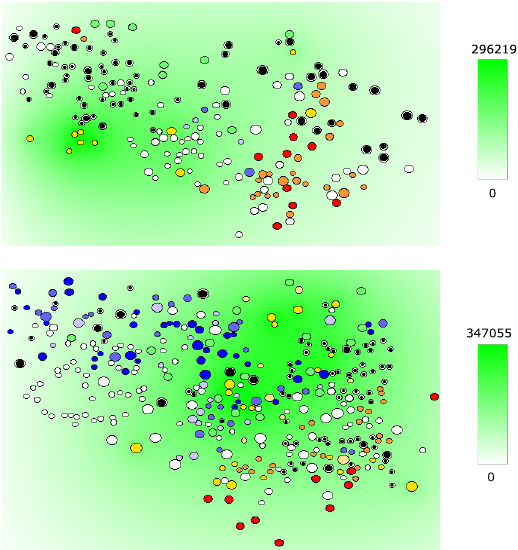
Figure 8. Snapshots of the simulation in which the concentration of IL-2 (in molecules/ µ L) is shown in green gradient. For cell notations, the same color code as in Figure 7 is used. ( top ) Three days after the virus transmission; ( bottom ) 12 days after virus transmission.